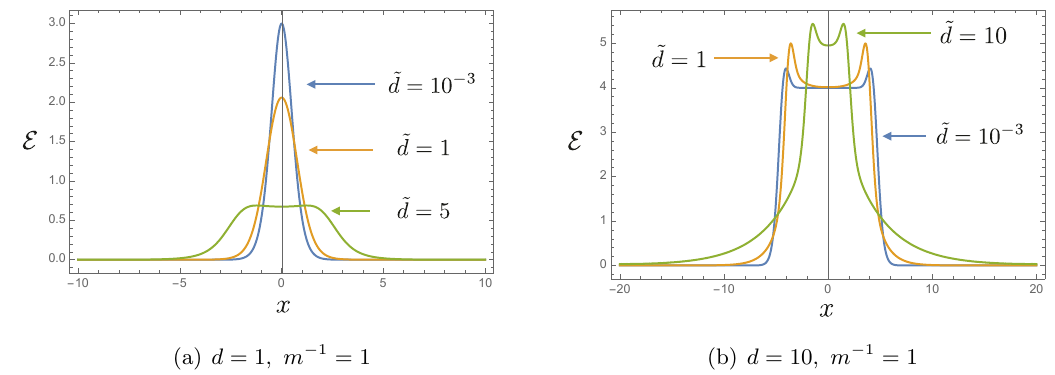
1 (left), the wall (cid:0) m (cid:0) 1 (cid:29)